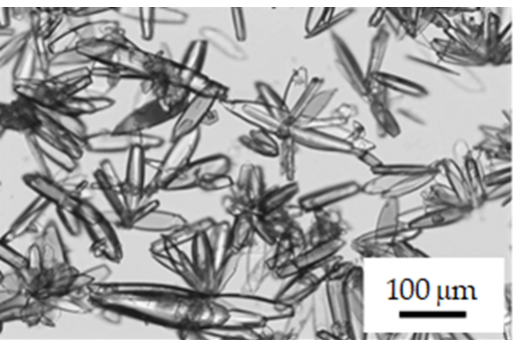
Figure 11. Optical micrograph of Form A obtained by the poor solvent crystallization from 80 v / v %